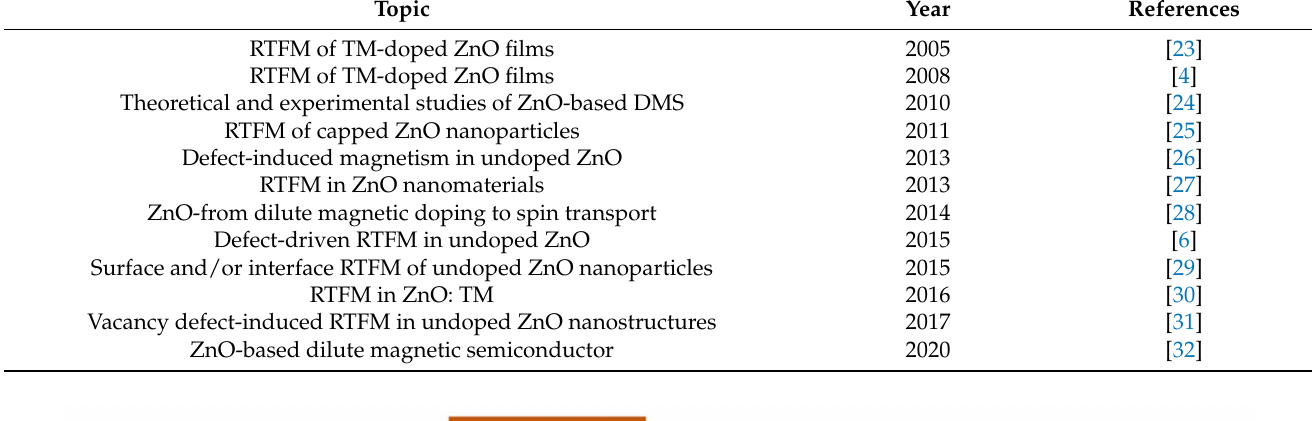
Table 1. Summary of research on ferromagnetic (FM) zinc oxide. RTFM (room-temperature ferromagnetism). Topic